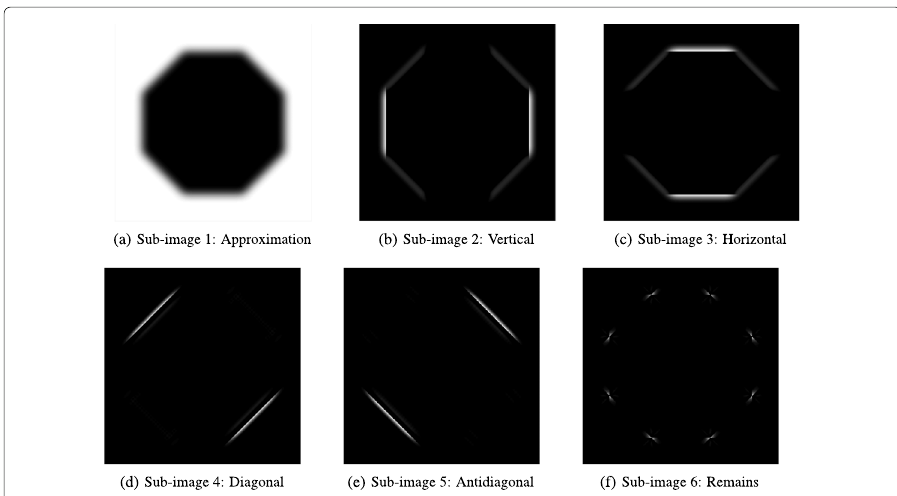
Fig. 11 The sub-images 1–6 of the “Octagon” image produced by the “ SSA-iSBD6-channelfilterbank ” according to the filter bank structure shown in Fig.